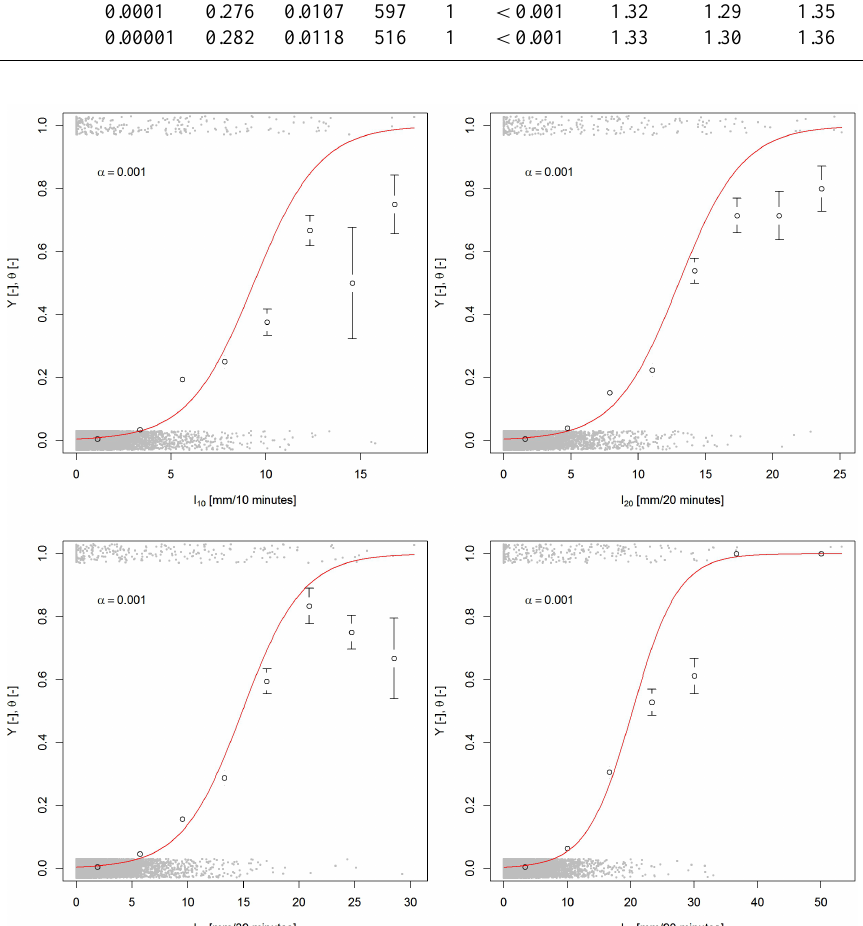
Fig. 3. Logistic functions (solid lines) fitted on property damage data. Plots are related to the cases of z = 10, 20, 30 and 90, using α = 1 × 10 − 3 . The grey small dots are the binary observations, either Y = 0 or Y = 1. A jitter function was applied on the binary observations to better visualize the density of the data points. The open circles are the calculated empirical proportions for eight non-overlapping, equally sized bins. The error bars represent one standard deviation of uncertainty on the empirical proportion